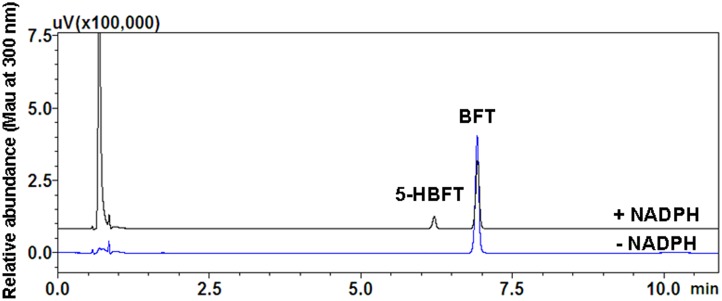
Representative UFLC-UV profile of BFT and its metabolite in HLM.